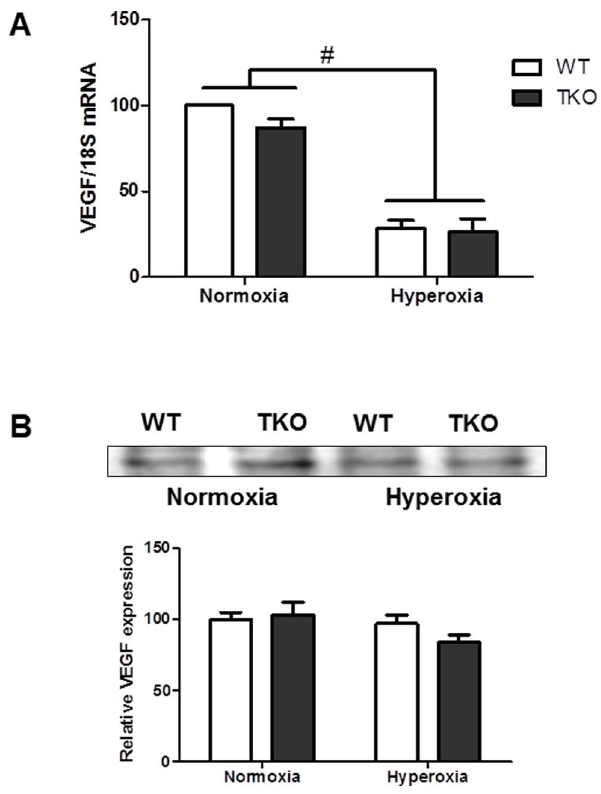
Figure 3. Deletion of TXNIP does not alter VEGF levels under normoxia or hyperoxia. (A) VEGF mRNA levels were detected from various groups using rt-PCR. (B) VEGF protein expression was examined using heparin-bound beads from p12 WT and TKO retinas. There was no change in levels of VEGF mRNA or VEGF expression between WT and TKO under normoxia. Hyperoxia caused significant decrease in VEGF mRNA compared to normoxia. Hyperoxia did not alter VEGF protein levels from normoxia in WT and TKO. ( # P , 0.05 Hyperoxia vs Normoxia, n=4–6).